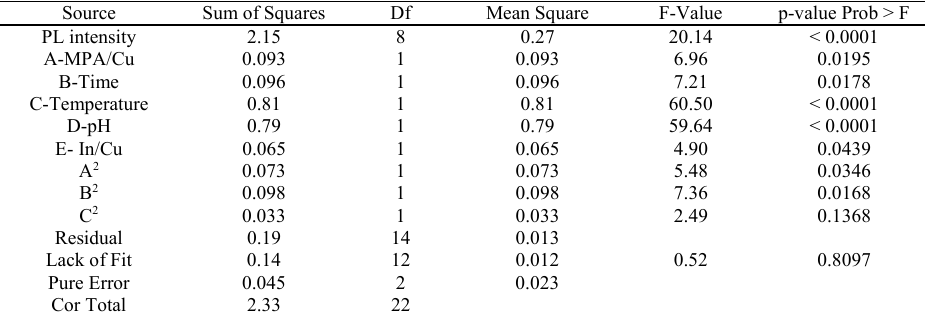
Fig. 2. The actual vs. predicted data for PL Table 3. ANOVA for PL intensity response Fig. 2: The actual vs. predicted data for PL intensity Table 3. ANOVA for PL intensity response